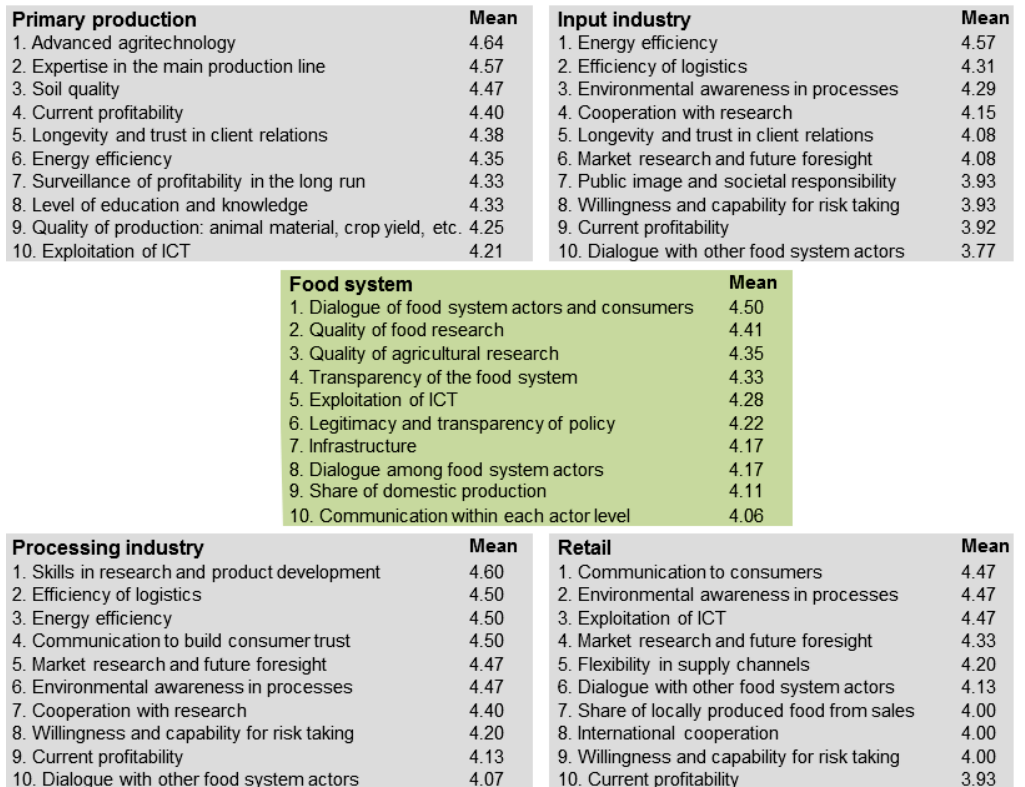
Fig. 3 . Determinants of adaptive capacity ranked as most significant for primary production (farm), the input industry, the food-processing industry, the retail, and the whole food system, according to the Delphi panel. A list of potential determinants to rank for significance was presented to the panel based on the brainstorming conversations. The scale was from 1 (no significance) to 5 (very high significance). ICT refers to information and communication technology. n = 11-18.